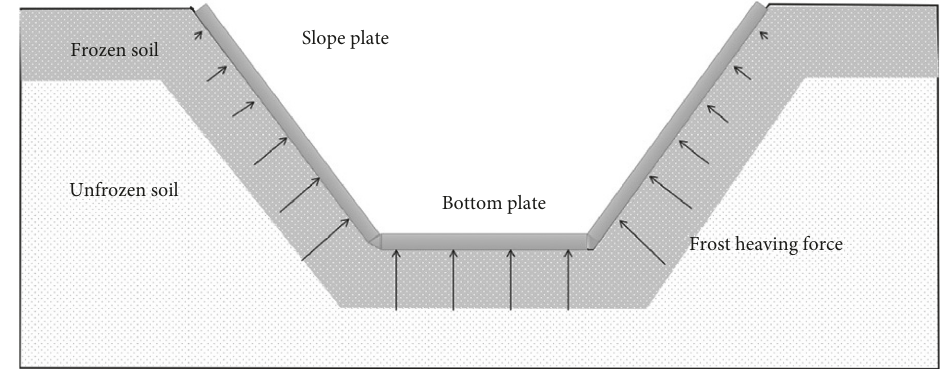
Figure 1: Schematic diagram of canal lining.